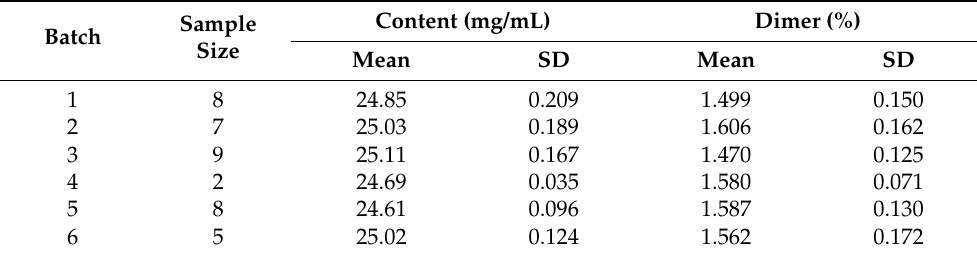
Figure 3. Observed data and β -expectation tolerance intervals for bevacizumab nominal content ( a ) and percentage dimer ( b ) for six batches used in this study ( β = 0.90 and (1 − α ) = 0.90). Table 1. Summary statistics for the CQAs and batches used in this study.